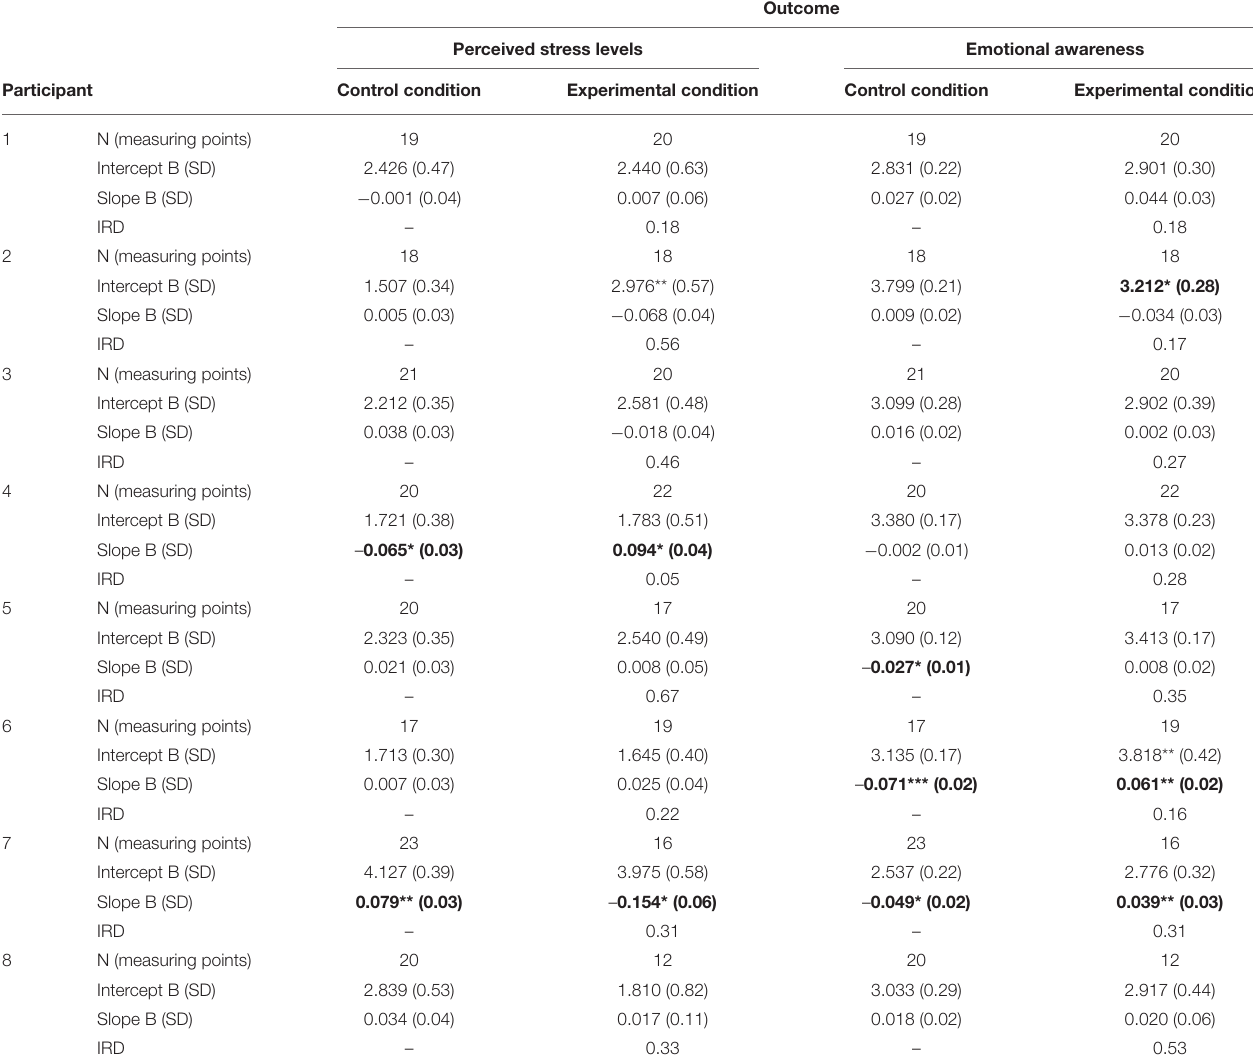
TABLE 1 | Summary of study results for dependent variables per participant and per condition. Outcome Perceived stress levels Emotional awareness Control condition Experimental condition Control condition